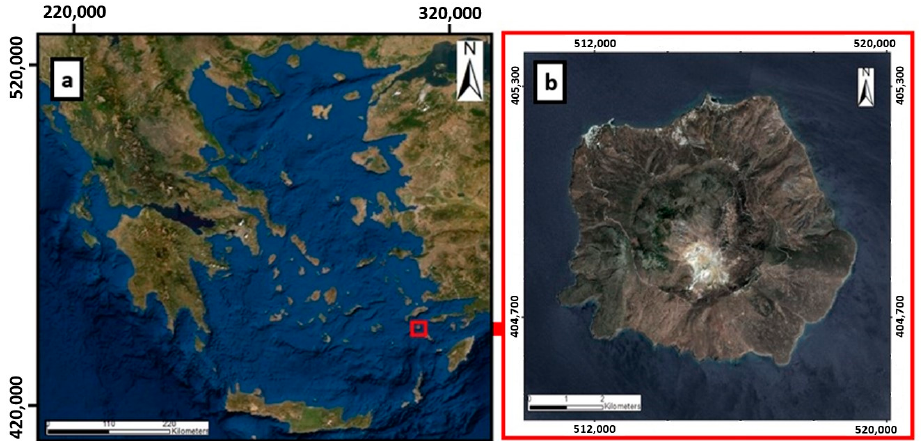
Figure 1. ( a ) Location of Nisyros island in the South Aegean Active Volcanic Arc (SAAVA) area (Greece). ( b ) Red square: atmospherically corrected Sentinel-2A MSI image of Nisyros island. The Nisyros volcano, located at the eastern end of South Aegean Active Volcanic Arc (SAAVA), is one of the most known volcanic environments of the Volcanic Arc of Greece. Nisyros is a Quaternary composite stratovolcano, which was formed during the Late Pleistocene-Holocene within an ENE–WSW trending neotectonic graben [69,70]. It is a volcano of 698-m height with a central caldera depression of 4-km diameter [66,67,69,71,72]. Its steep walls present a drop of 300–400 m [68]. The Nisyros volcanic edifice was formed during the Late Quaternary and lies above an Alpine basement of Mesozoic limestones [73,74]. It is characterized by calc-alkaline pyroclastic deposits and lavas of basaltic andesitic, dacitic, rhyodacitic, and rhyolitic composition formed during several explosive cycles from 160 to 25 ka [69,75]. The caldera hosts a known hydrothermal field that includes prehistoric and historic hydrothermal craters (e.g., 1871–1873) (Figure 1b) [69]. In this study, we utilized the most recent “Geological Map of the Island of Nisyros (Dodecanese Archipelago)” 1:15,000 [68] which we digitized and georeferenced. The geological map synthesizes information from several previous geological maps of the area [71,72,76–80]. Within the caldera, 11 lithostratigraphic units (LSUs) are present (in terms of age and relative lithology) from the most recent to the older explosive cycles, as shown in Figure 2 and [68]. More specifically, the units are: (LSU1) debris flow and lacustrine deposits related to hydrothermal explosions that took place on the SW sector of the Nisyros caldera; (LSU2) rhyodacitic lava domes and voluminous lavas; (LSU3) rhyolitic lava flows with glass-rich flows, vitrophyric and perlitic facies, internal layering and folding, and amphibole-rich enclaves of basalt-andesitic composition creating a blocky flow surface covered by a paleosol; (LSU4) mainly lag-breccia (near-vent accumulated large lithics); (LSU5) rhyolitic dark grey, glass-rich lava flows and neck with reddish banding, perlitic textures, minor block, and ash flows deposits; (LSU6) basaltic andesite pyroclastic succession, which consists of base surges and pyroclastic flows; (LSU7) andesitic lava flow (max. 40 m) with sole of red scoria derived from northern and central eastern eruptive centers; (LSU8) andesitic pyroclastic sequence of (max. 35 m), from bottom to top, reddish pumice fall with fine layers of laminated surges, pyroclastic flows, surges, and final pumice fall located at the northern and northeastern caldera walls; (LSU9) basaltic andesite scoria-rich lava flows located at the northern and northeastern caldera walls; (LSU10) Quaternary volcano-sedimentary alluvial/beach deposits; and (LSU11) Quaternary volcano- sedimentary old and recent scree deposits.